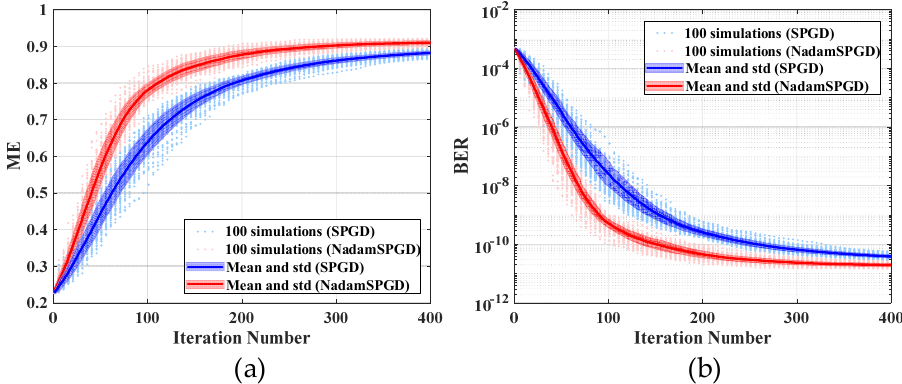
Figure 5. Comparison of the optimization curves between SPGD and NadamSPGD: ( a ) ME curves; ( b ) system BER curves.